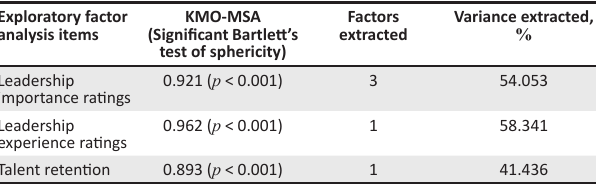
TABLE 2: Exploratory factor analysis results. Exploratory factor analysis items